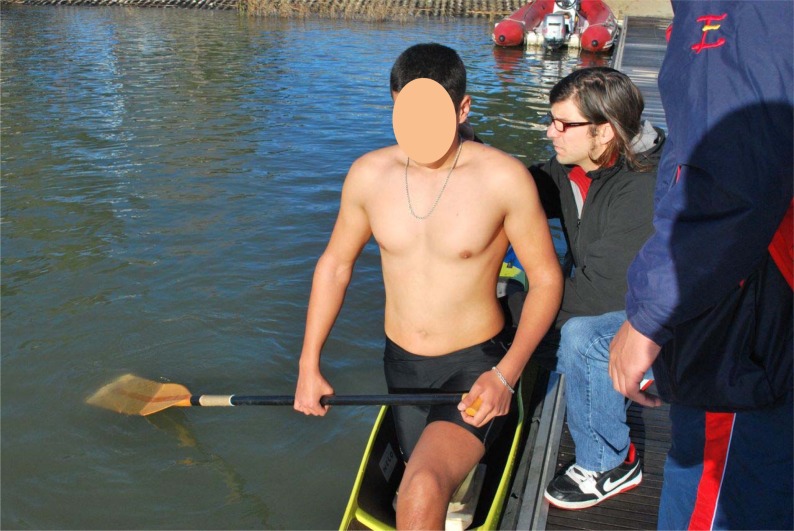
Base position in the canoe